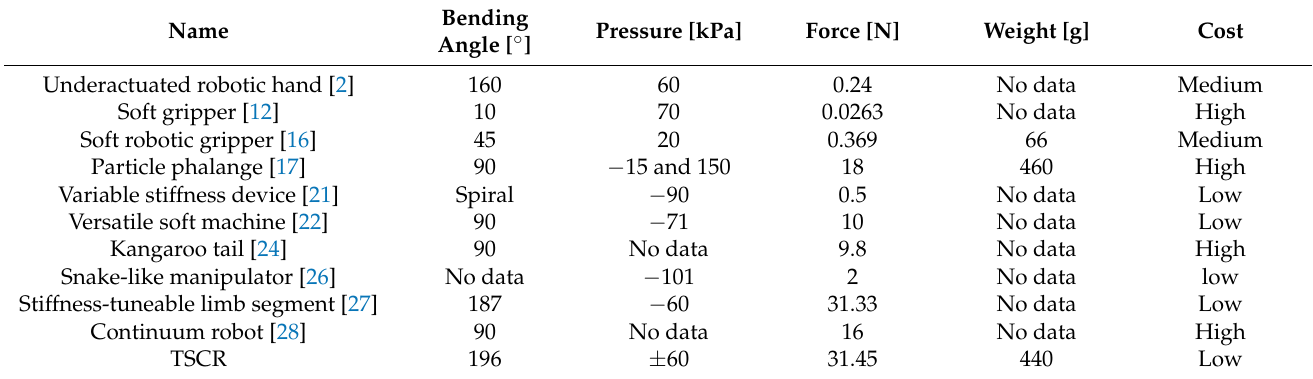
Table 1. Multidimensional comparison of different